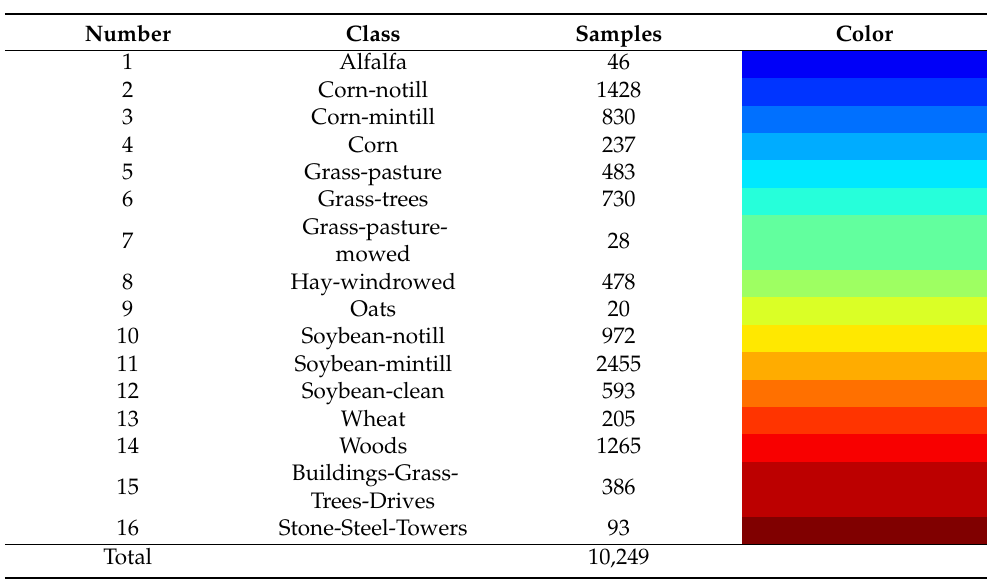
Table 2. The information of each class in IP.